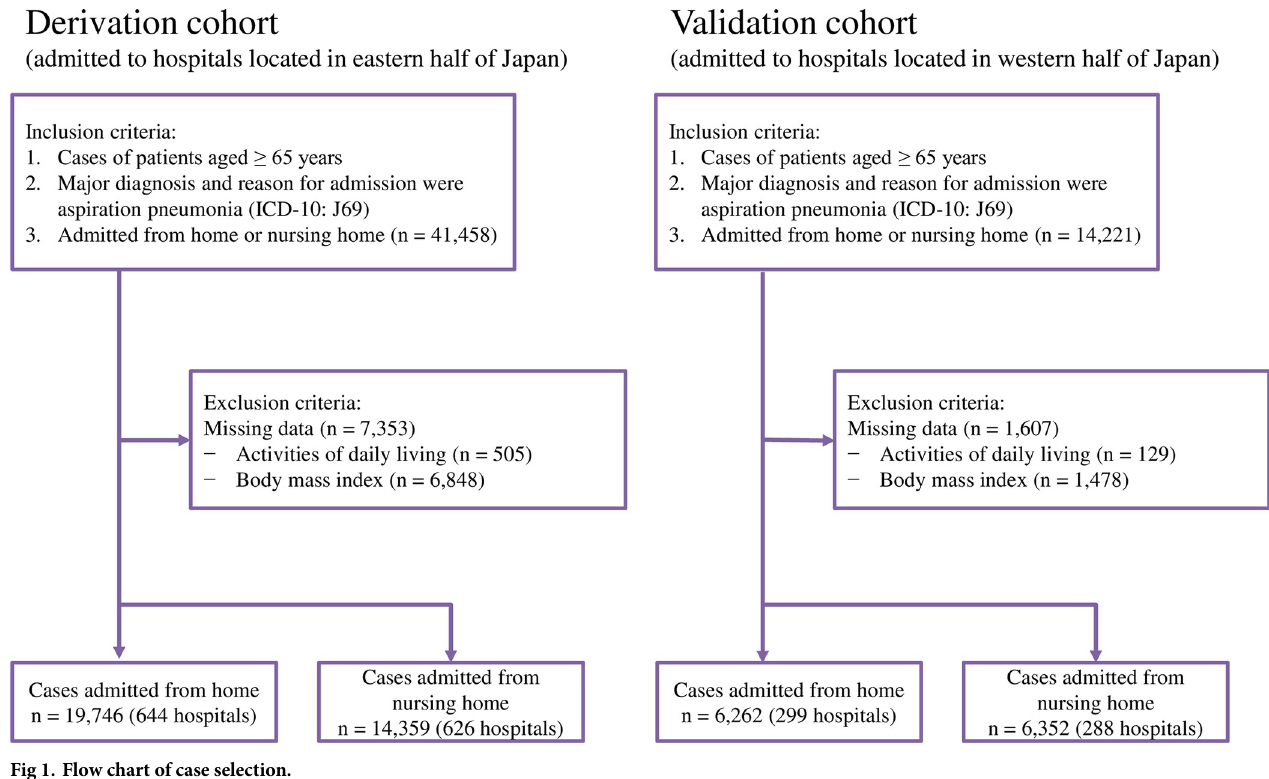
Fig 1. Flow chart of case